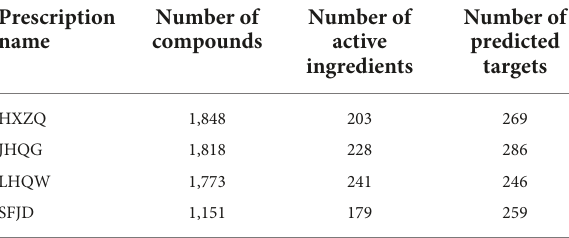
TABLE 2 Specific information of each